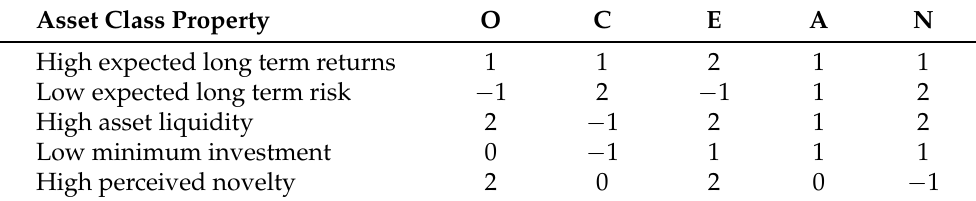
Table 2. A matrix Q describing the association between prototypical personality traits—openness (O), conscientiousness (C), extraversion (E), agreeableness (A), and neuroticism (N)—and a set of inherent properties of each asset class. Values are in { n ∈ Z | − 2 ≤ n ≤ 2 } and represent a highly negative, negative, neutral, positive and highly positive association, respectively.